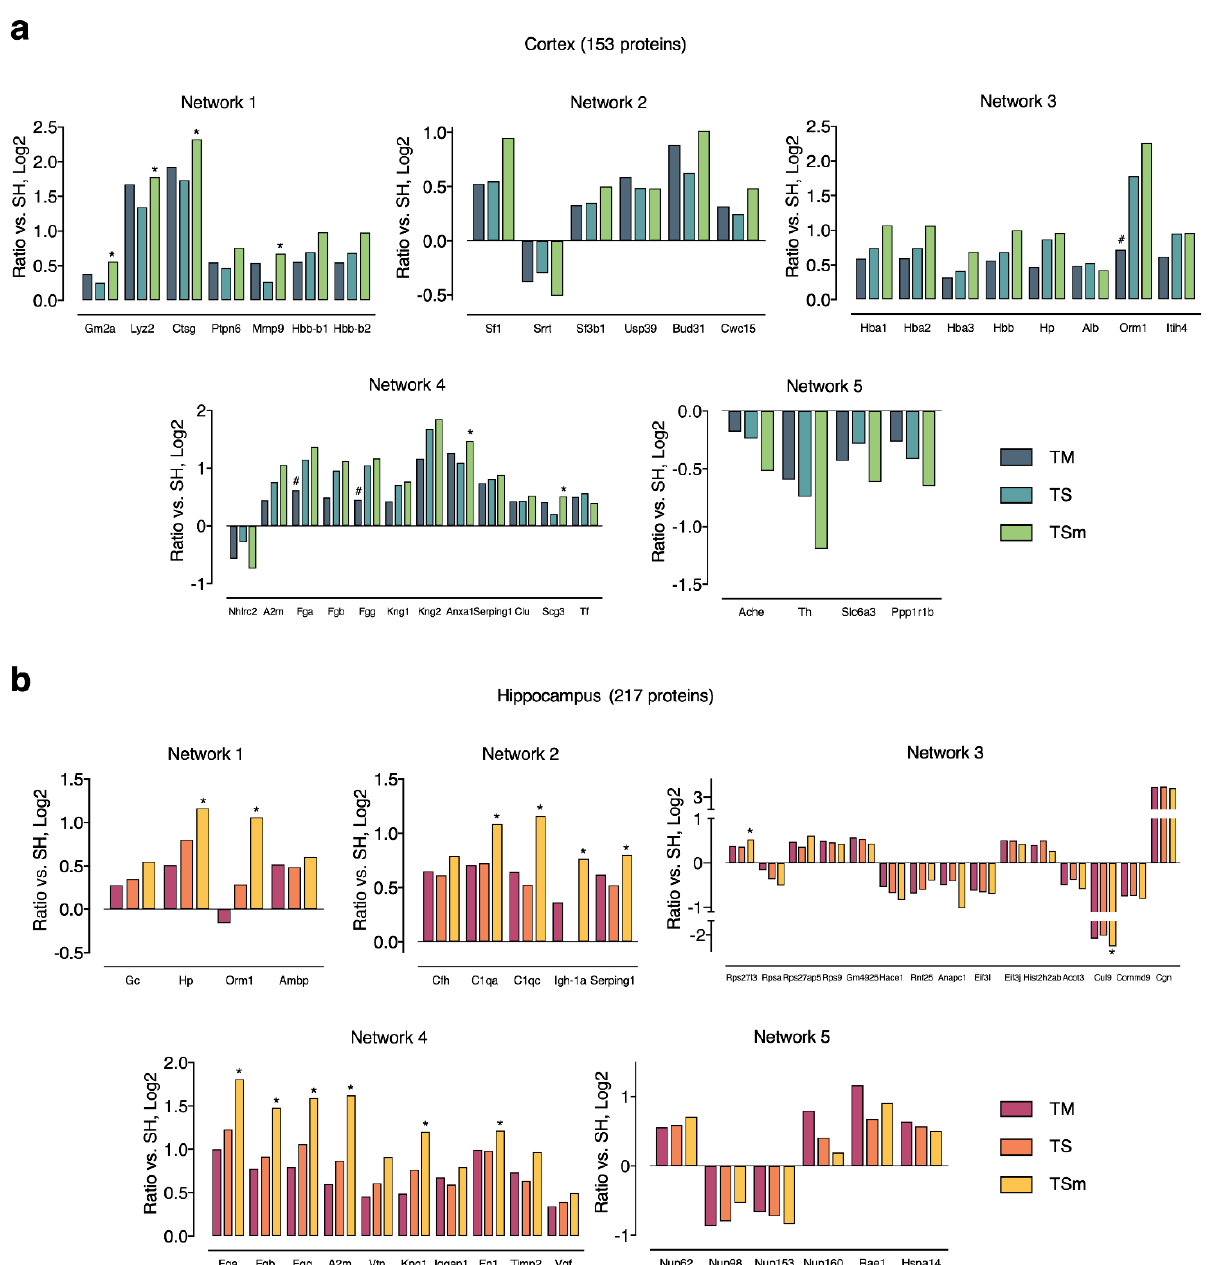
Figure 5. Expression profiles of MA-unique APs from each PPI network in ( a ) cortex and ( b ) hippocampus. Asterisks indicate statistical significance (i.e., p < 0.05) between TS and TSm, while hash signs indicate statistical significance (i.e., p < 0.05) between TS and TM.